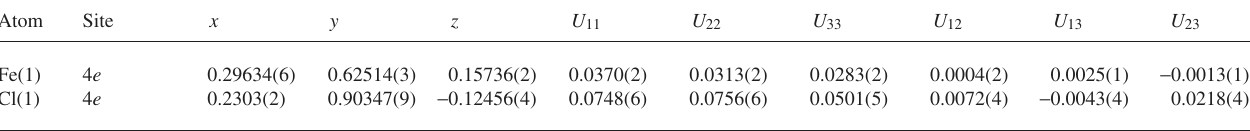
Table 3. Atomic coordinates and displacement parameters (in Å 2 )